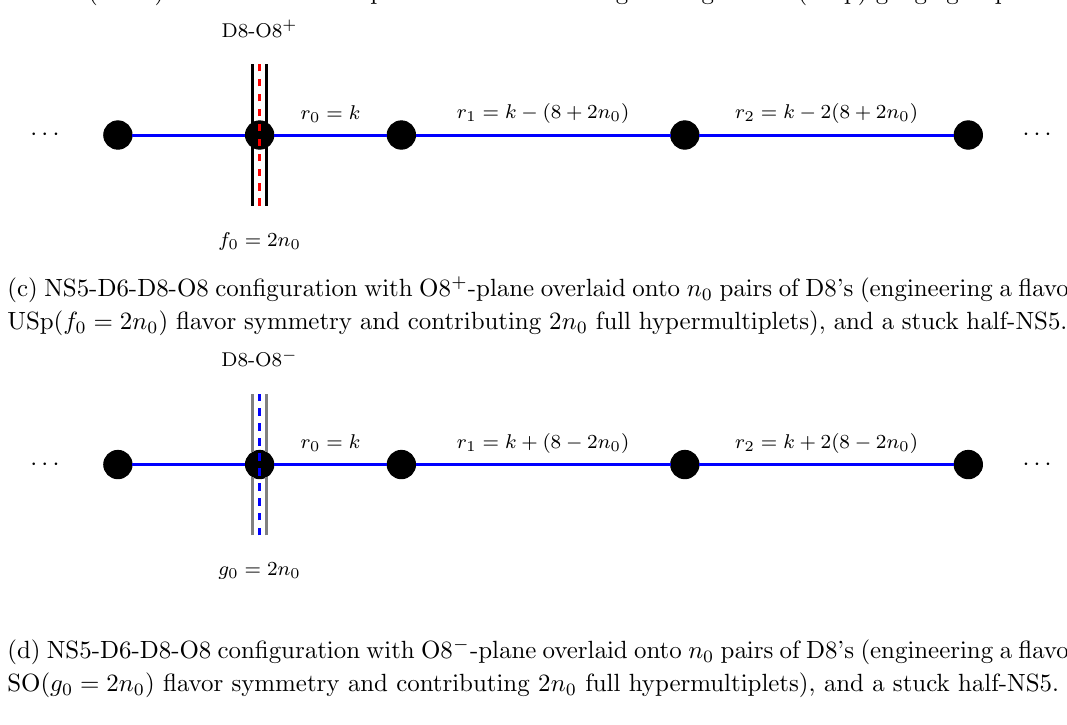
(b) NS5-D6-D8-O8 con(cid:12)guration with an O8 (cid:0) -plane between an NS5 and its image, and crossing the 0-th D6 stack. A blue dashed line and two vertical gray lines represent an O8 (cid:0) overlaid onto n 0 pairs of D8-branes, engineering an SO(2 n 0 ) (cid:13)avor group and contributing 2 n 0 half-hypermultiplets. A blue (black) horizonatal line represents a D6 stack engineering an SU ( USp) gauge group.